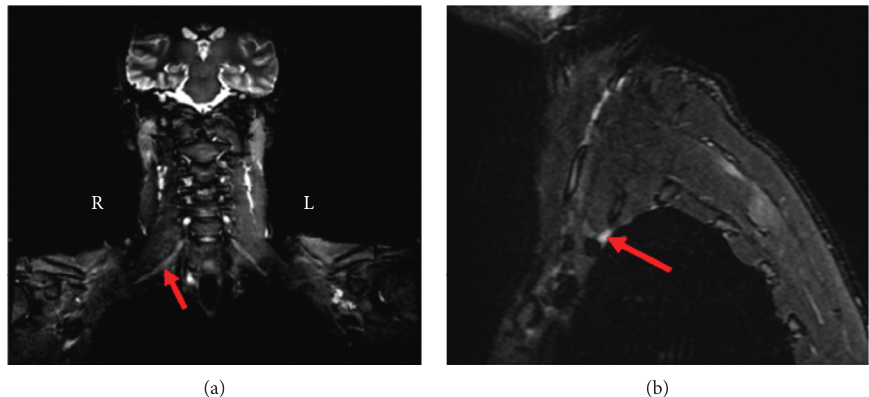
Figure 1: Chest MRI of the patient with inflammatory brachial plexopathy. (a) Coronal chest and (b) sagittal chest, T2 weighted and fat- suppressed MRI images without contrast show elevated T2 signaling indicating subtle thickening in the right brachial plexus structure at the time of